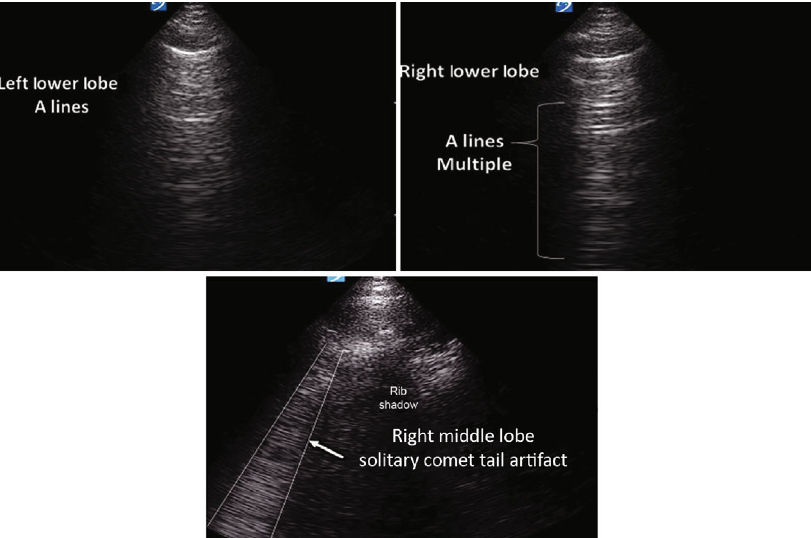
Figure 3: The patient ’ s bedside ultrasound images after extubation revealed horizontal artifact consistent with normal lung parenchyma, and only a single comet tail artifact noted after bedside ultrasound of all lung fi